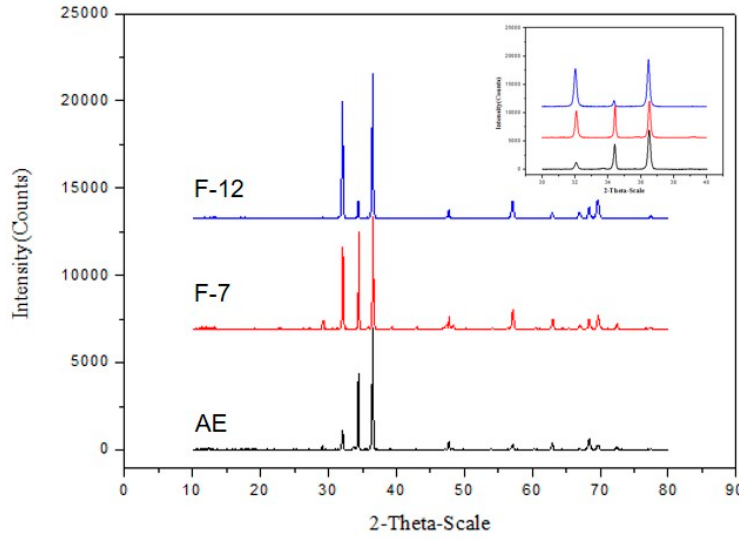
Figure 7. X-ray di ff raction pattern of di ff erent samples. Figure 7. X-ray diffraction pattern of different samples. Table 3. Contribution of work hardening to the yield strength of the